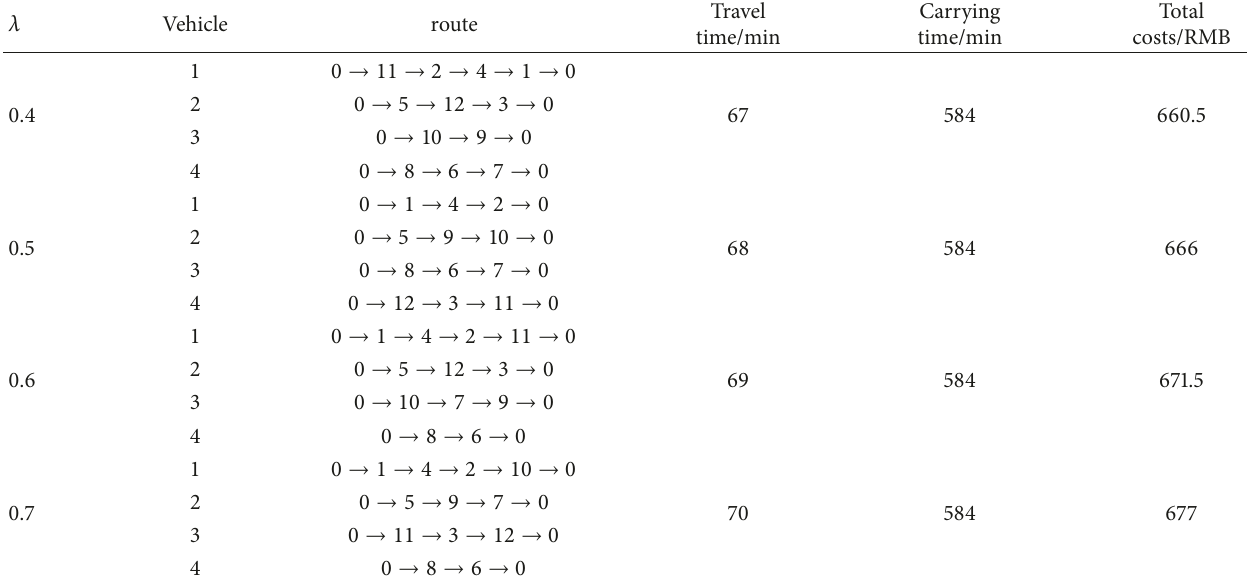
Table 2: The optimal result of FBSP model for the different capacity ratio.